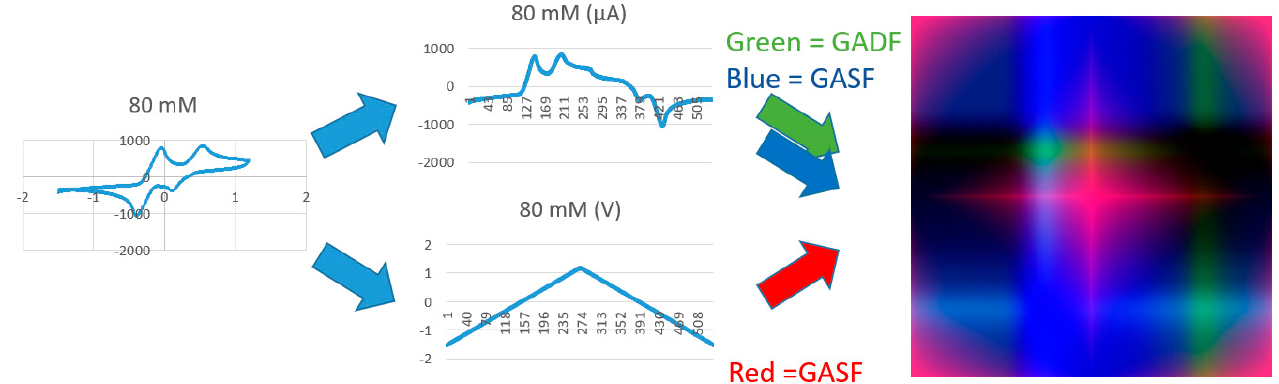
Sensors 2022 , 22 , x FOR PEER REVIEW